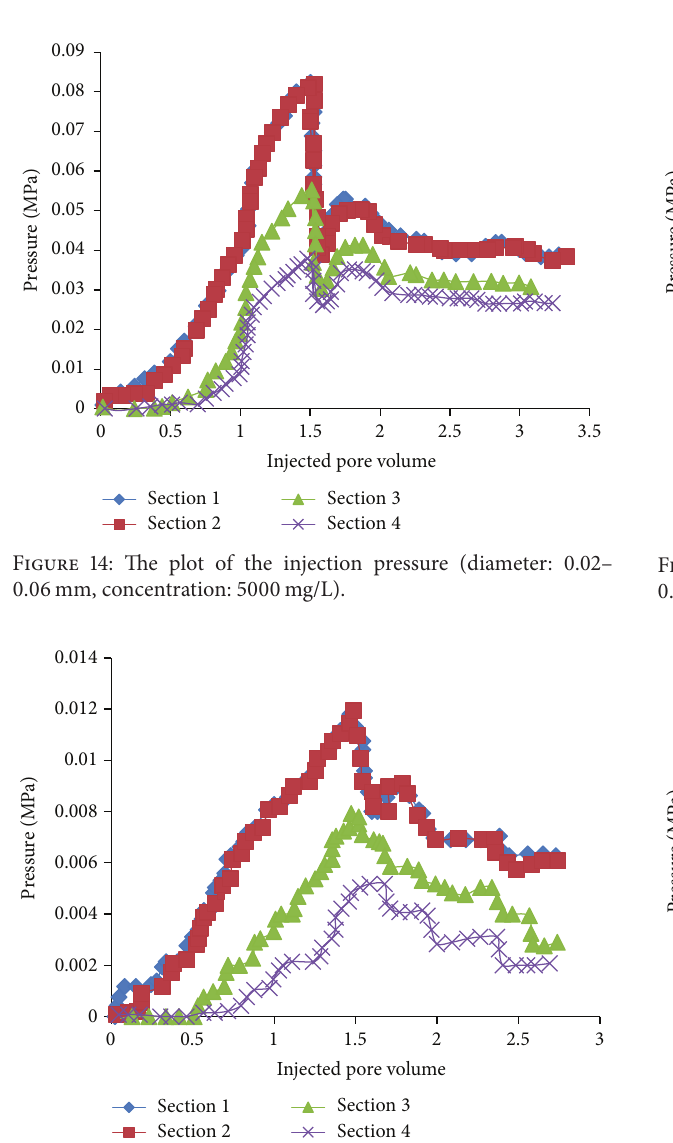
Figure 17: The plot of the injection pressure (diameter: 0.08– 0.1 mm, concentration: 5000